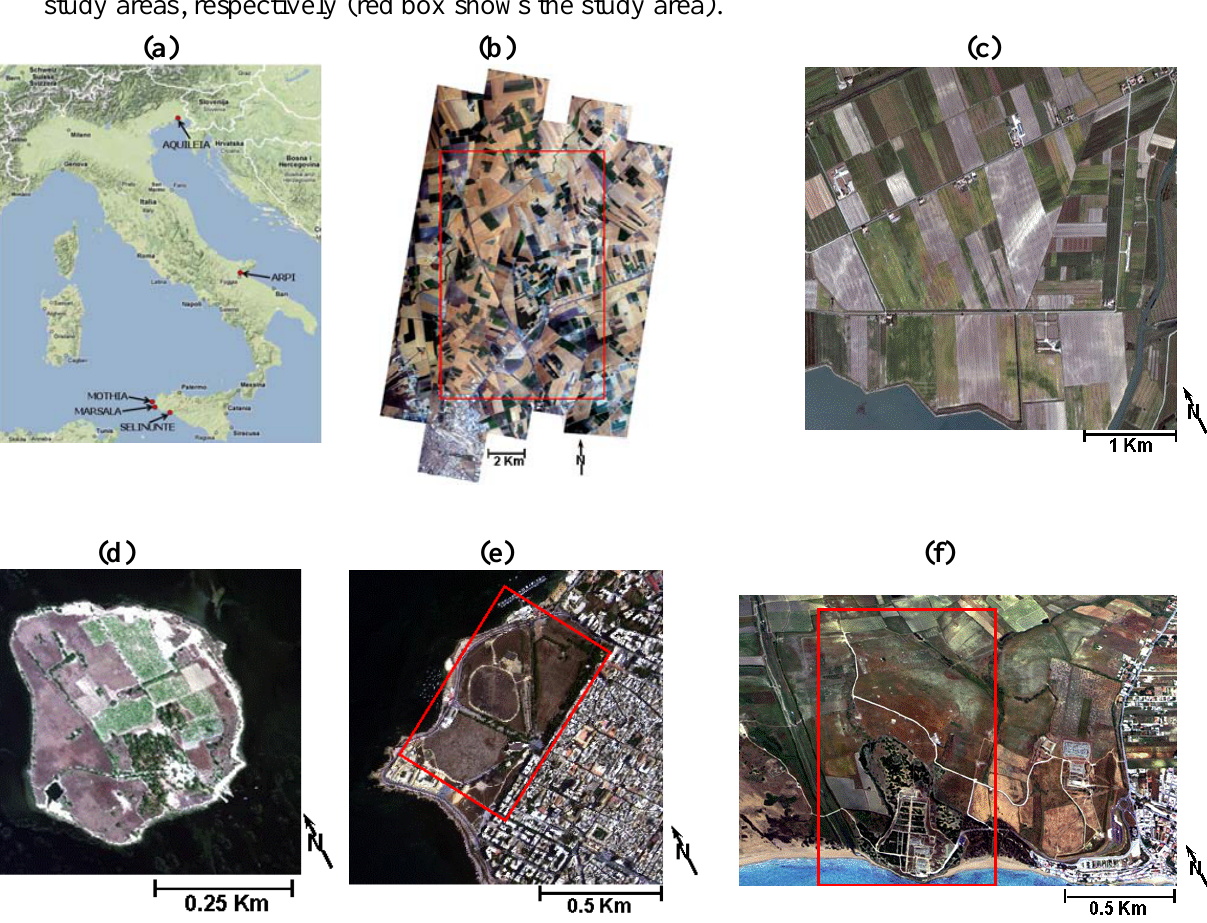
Figure 1. (a) Location of the five study areas over a regional map. (b) MIVIS stripes acquired on the Arpi archaeological area (red box shows the study area), (c) (d) (e) (f) MIVIS images acquired over the Aquileia (resize of 755 x 920 pixels), Mothia (resize of 165 x 165), Marsala (resize of 330 x 330 pixels) and Selinunte (resize of 400 x 920 pixels) study areas, respectively (red box shows the study